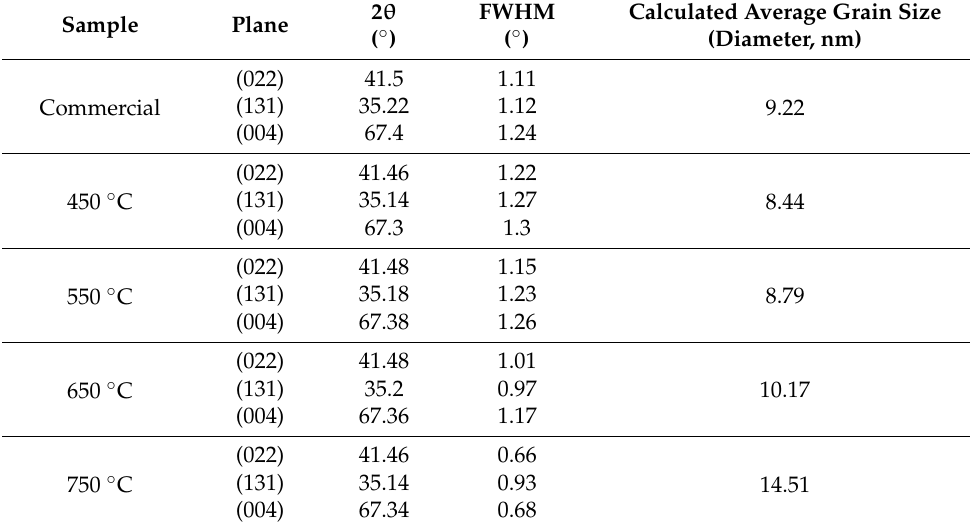
Figure 3. X-ray diffraction patterns of the commercial NZF nanoparticles and electrospun NZF nanofibers calcined at 450 °C, 550 °C, 650 °C, and 750 °C. Table 1. The calculated average crystallite size of calcined Ni 0.5 Zn 0.5 Fe 2 O 4 nanofibers.